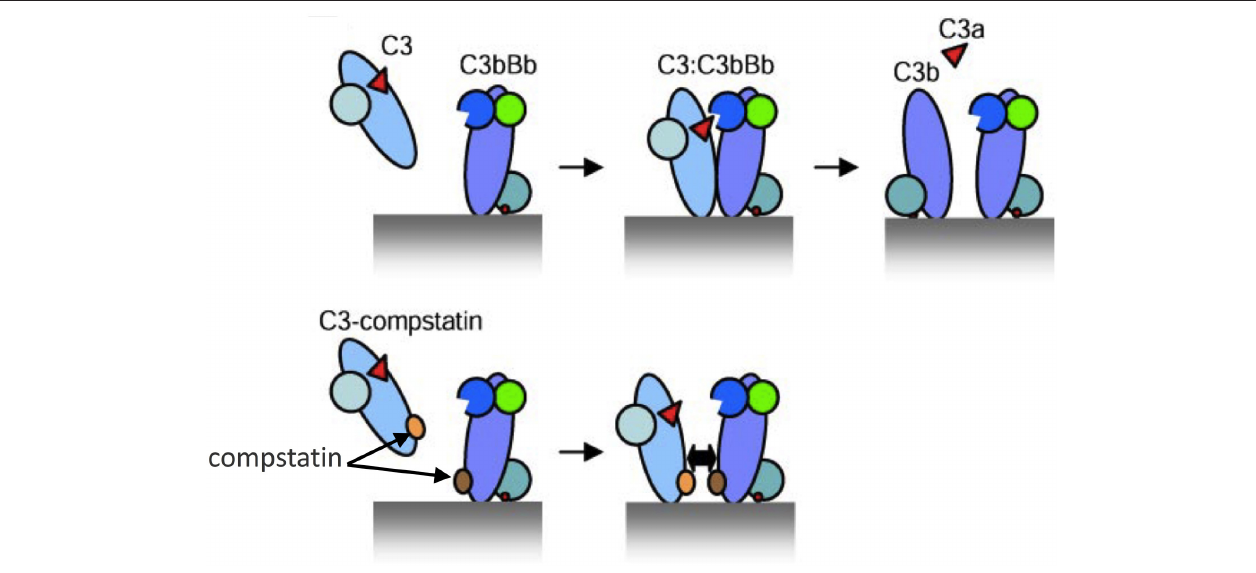
FIGURE 2 | Model of C3 activation and its inhibition by compstatin. (Top) Depiction of key protein interactions resulting in the formation of C3 convertase on a target surface (e.g., a microbial cell surface). Native C3 binds to the convertase (C3bBb) and is cleaved into its active fragments, C3a and C3b. (Bottom) Compstatin acts by blocking protein-protein interaction. Specifically, compstatin binds both native C3 and C3b and sterically hinders the binding of native C3 by C3 convertases, hence preventing C3 cleavage into its active fragments. From ref. 87. Used by